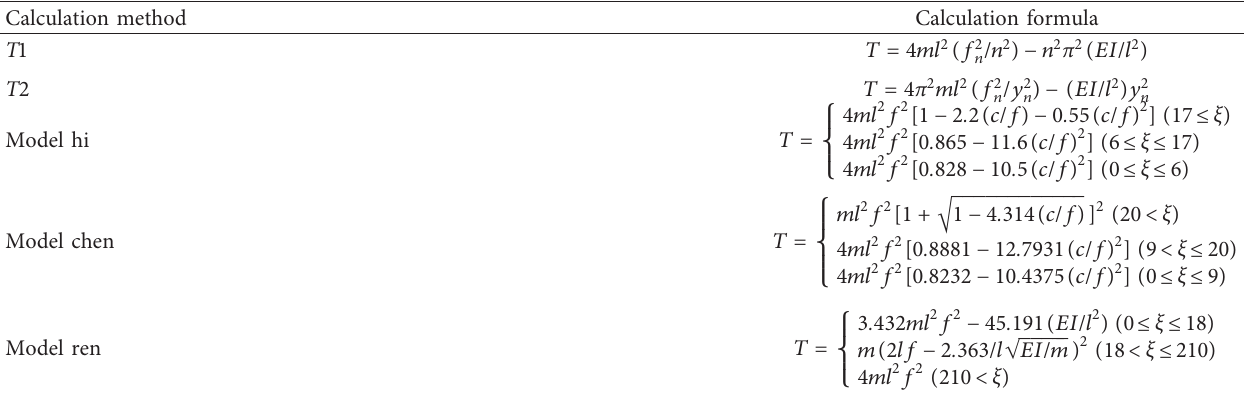
Figure 20: Frequency spectra of some suspenders: frequency charts of (a) S1n suspender; (b) S2n suspender; (c) S3n suspender; (d) S4n suspender; (e) S5n suspender; (f) S6n suspender; (g) S7n suspender; (h) S8n suspender; (i) S9n suspender; and (j) S10n suspender. Table 7: Common calculation methods.